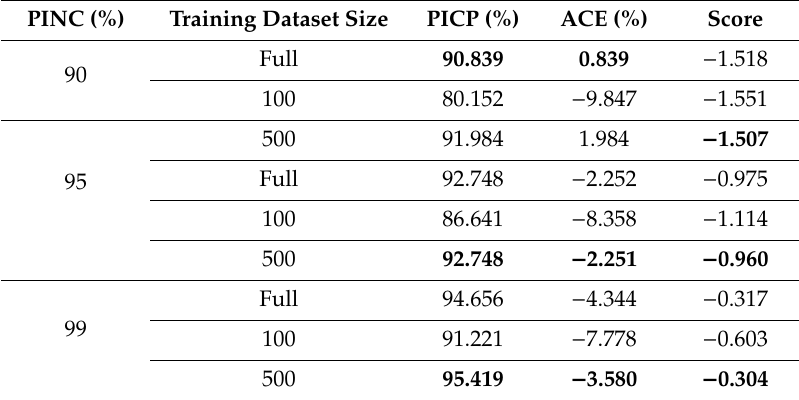
Table 6. Evaluation results of PIs in Y(3) prediction.